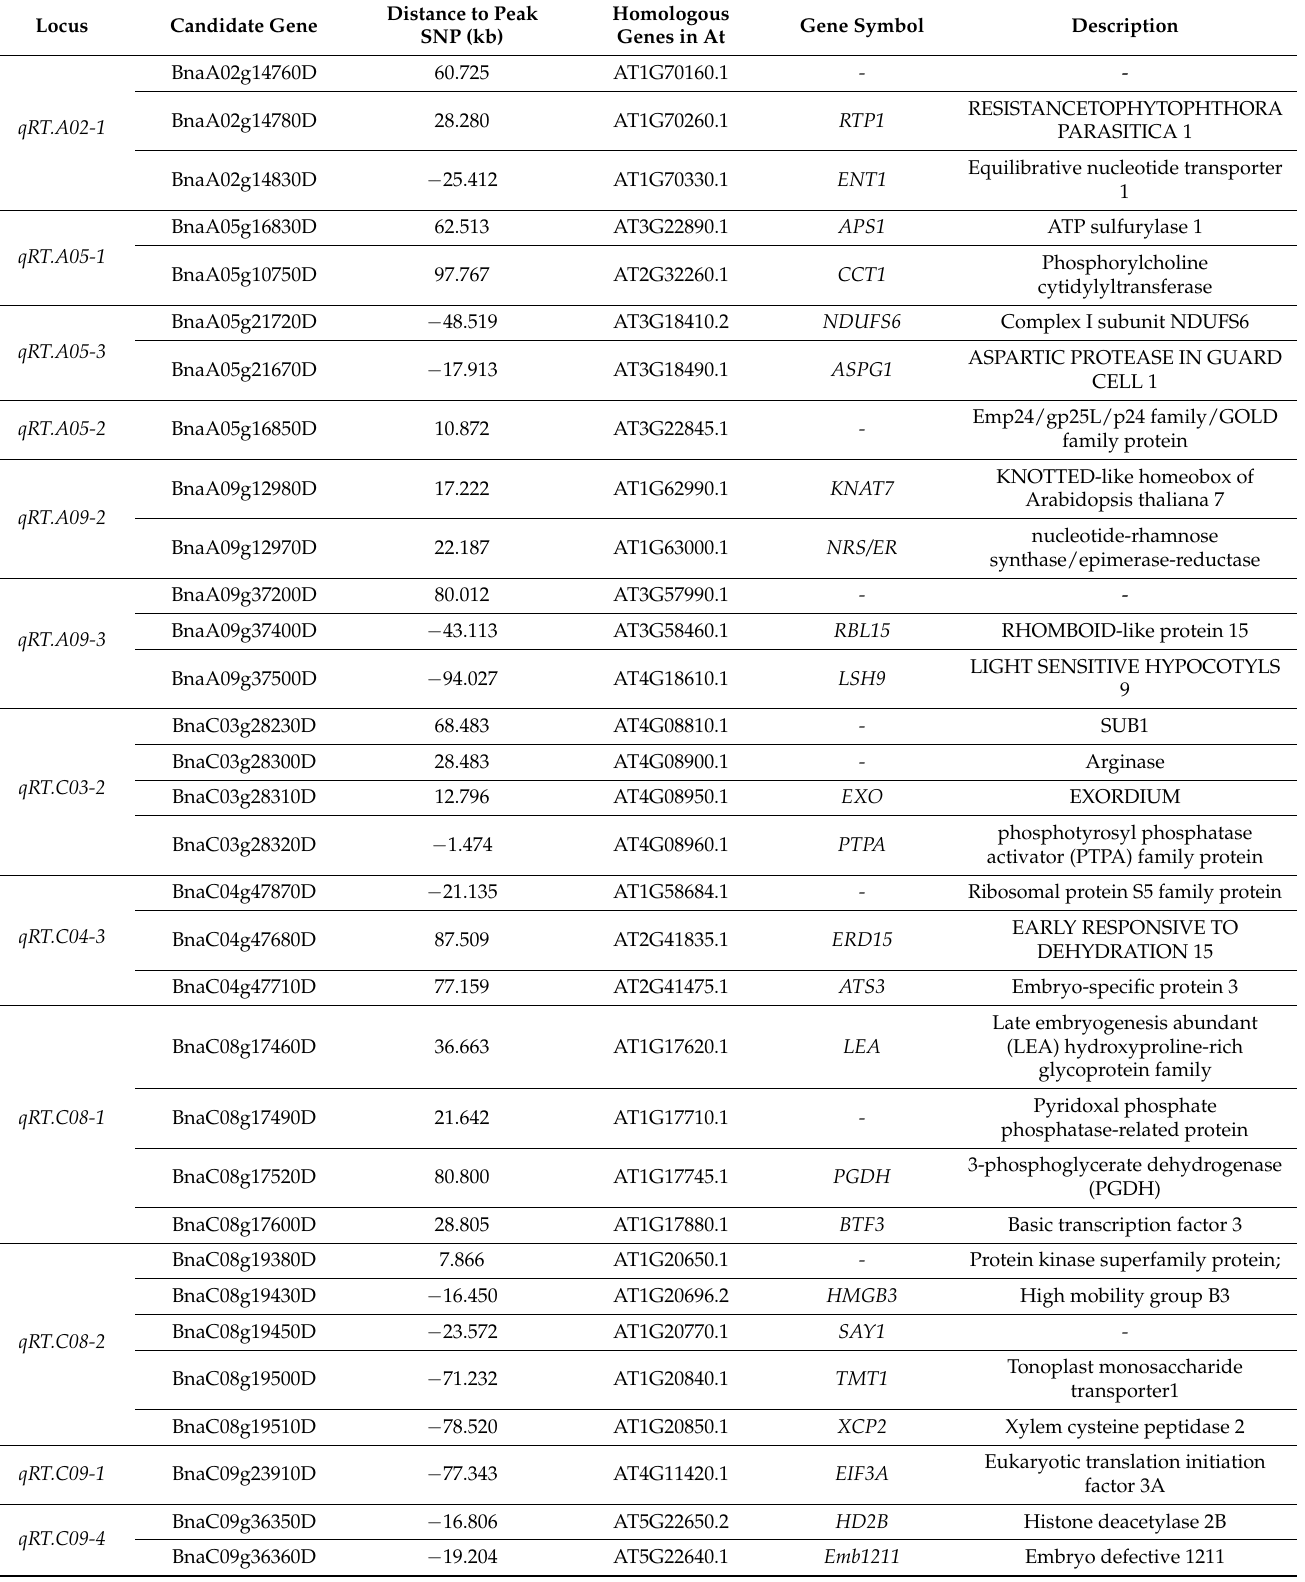
Table 4. Candidate genes for root-related traits within 100 kb upstream and downstream of the lead